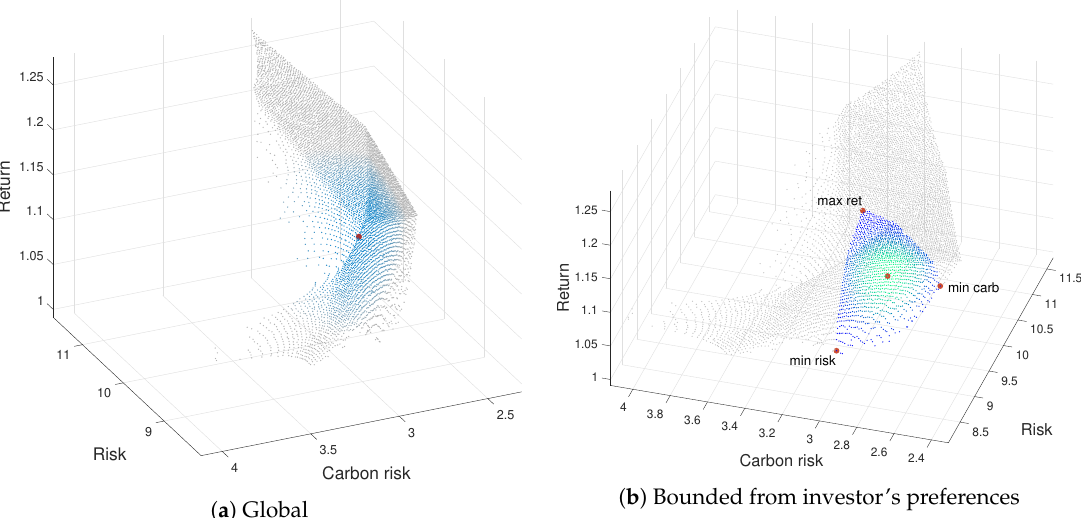
Figure 1. Approximated ε -Pareto front generated by ev-MOGA algorithm for the tri-criterion problem.